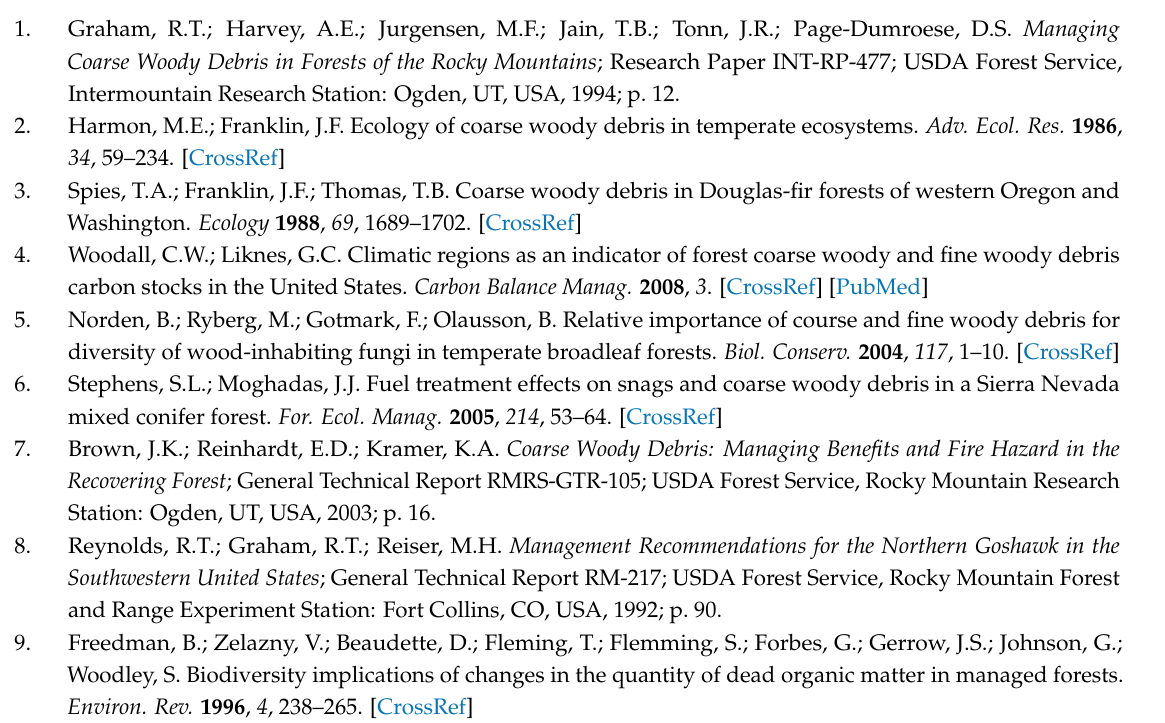
Table S1: Variable names and units used for RF model runs and calibration used in the analyses. Author Contributions: A.D.G. was involved with the study design, data analysis, and is the primary author of the manuscript. J.D.S. was involved with study design development, dataset assembly, assisted with data analysis, and contributed to the writing process for the